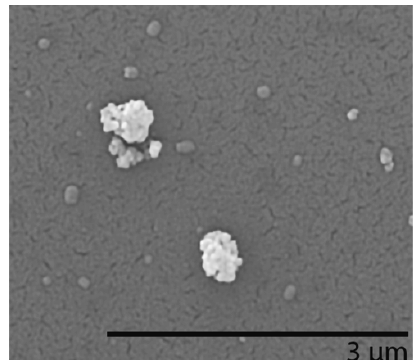
Figure 2. Scanning electron microscopy (SEM) images of CeO 2 NPs aerosolized in the PreciseInhale system and deposited on collagen-coated cover slips put in transwells in the Xpose ALI unit.